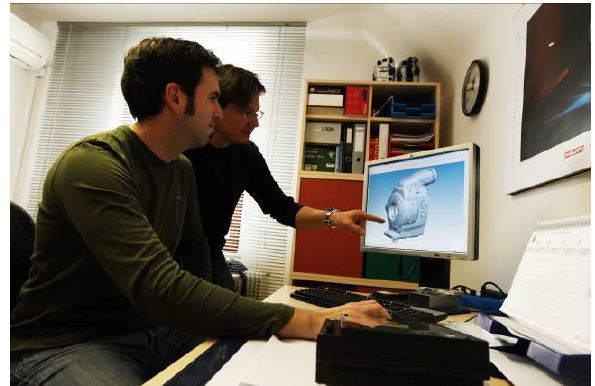
Figure 4. Harald Hordosh and his engineer Gunter Rupreckter started their project with a 3D scan of the cameras to be housed.